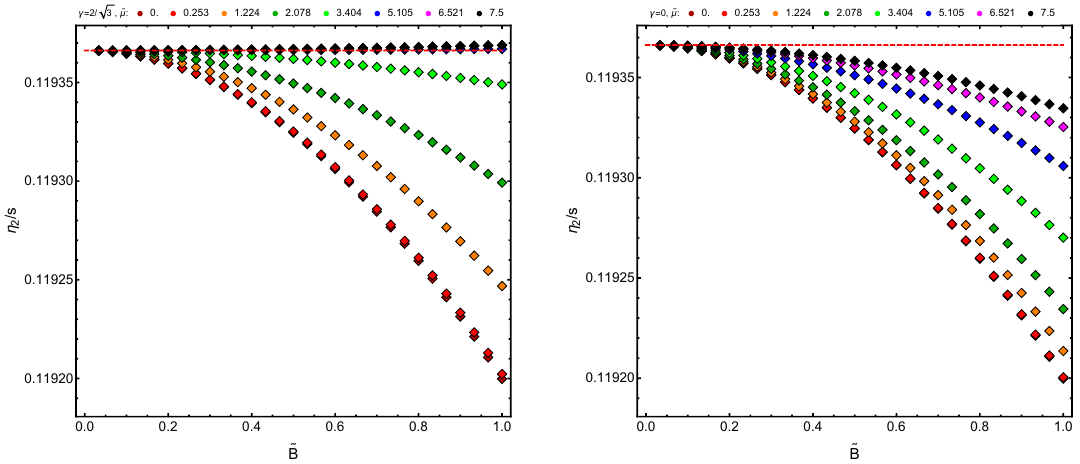
Figure 11 . Dimensionless ratio of bulk viscosity η 2 and entropy density for fixed chemical potentials ˜ µ . The red dashed line indicates the value for η at zero magnetic field, namely 3 / (8 π ) . Note the 2 /s √ behavior similar to η 3 there is a distinctly different behavior from /s , namely that for γ = 2 / k the case γ = 0 : for the largest three displayed chemical potentials, i.e. for ˜ µ ≥ 5 , the value of the transport coefficient η increases with ˜ B , while it always decreases for γ = 0 2 /s